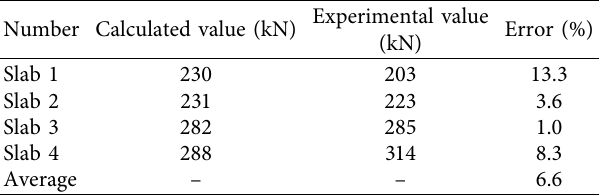
Table 8: Comparison between theoretical and experimental values of ultimate